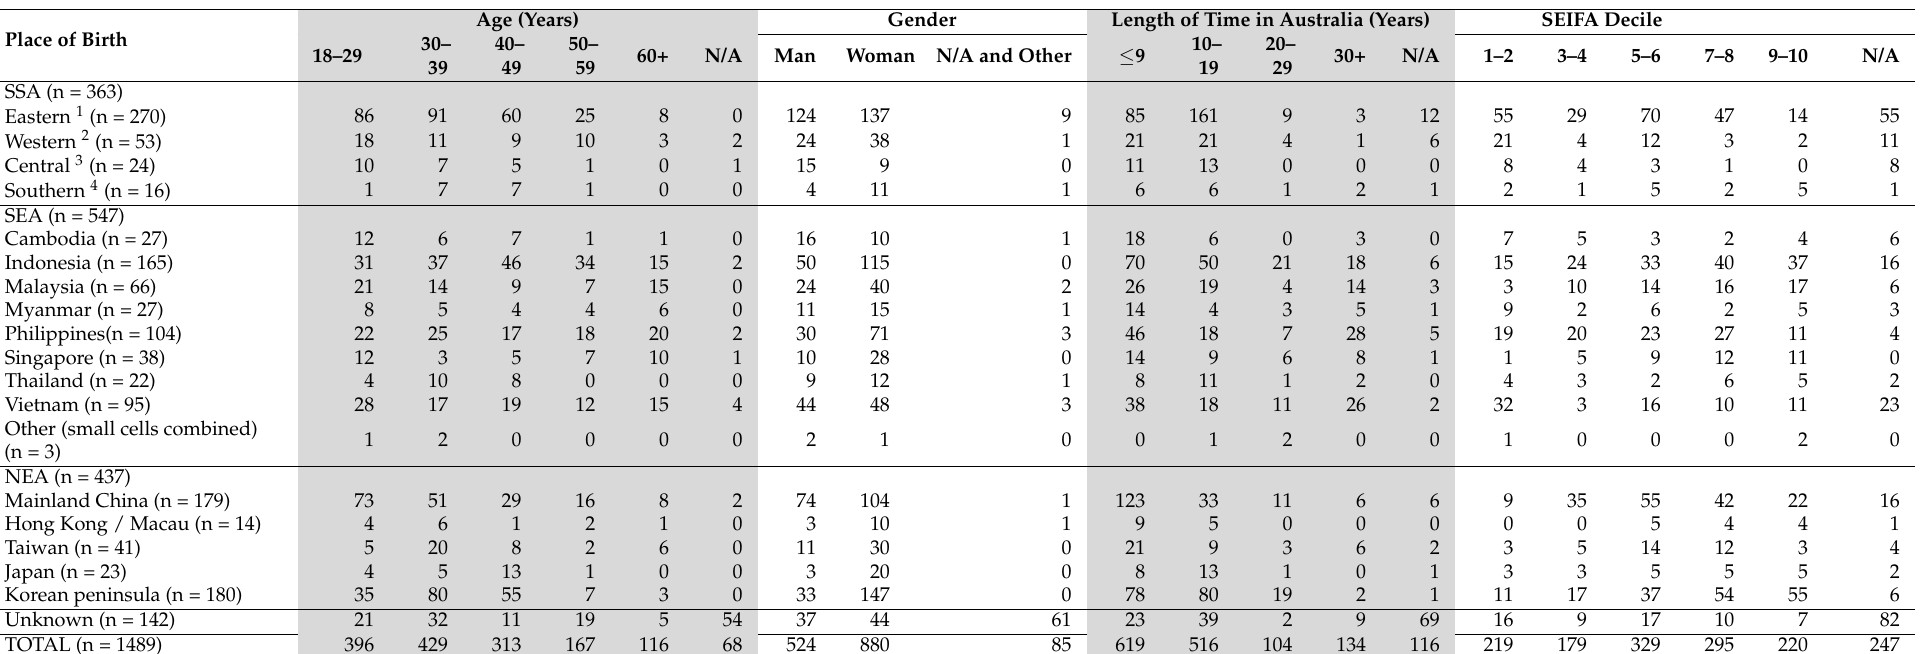
Table 1. Number of survey respondents, by region of birth, age, gender and time in